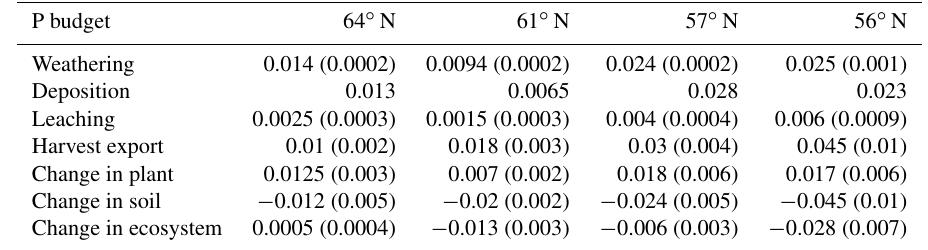
Table B1. Simulated annual P budget, including the associated uncertainty range (mean ± SD in gPm − 2 yr − 1 ).